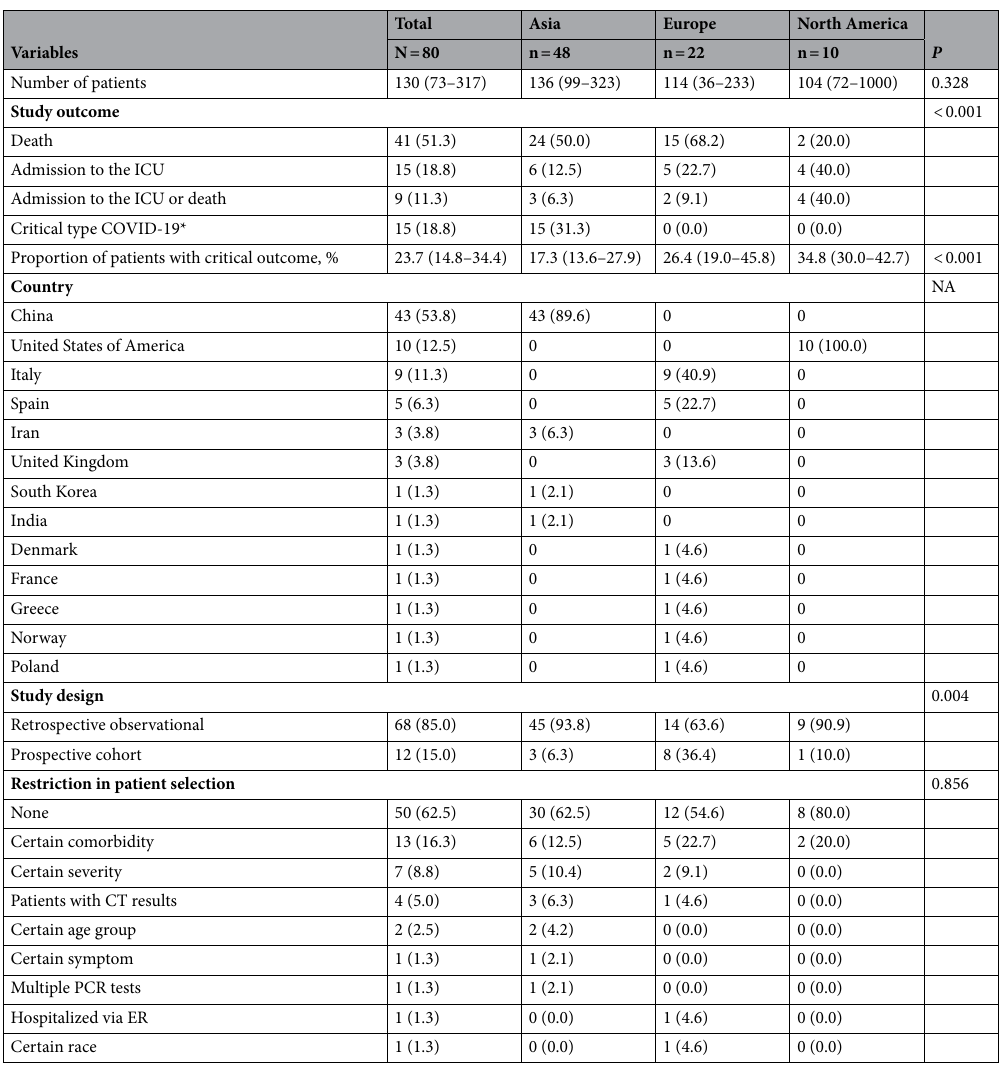
Table 1. Characteristics of studies included in analysis. Numbers are presented as number (percentage) or median (interquartile range). P -values are calculated from chi-square test, Fisher’s exact test, or Kruskal–Wallis test. *Critical type COVID-19 refers to disease extent with respiratory failure, septic shock, and/or multiple organ dysfunction. ICU intensive care unit, NA not applicable, CT computed tomography, PCR polymerase chain reaction, ER emergency